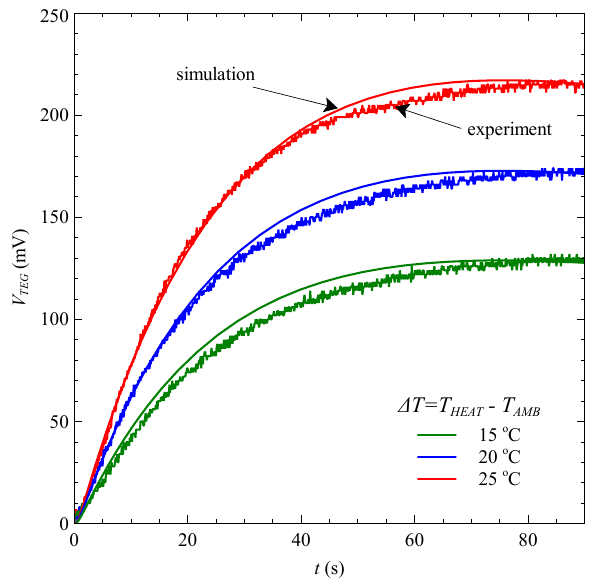
Figure 9. Generated voltage vs. time of the considered WSN node with TEG1 and without electronic devices for three temperature